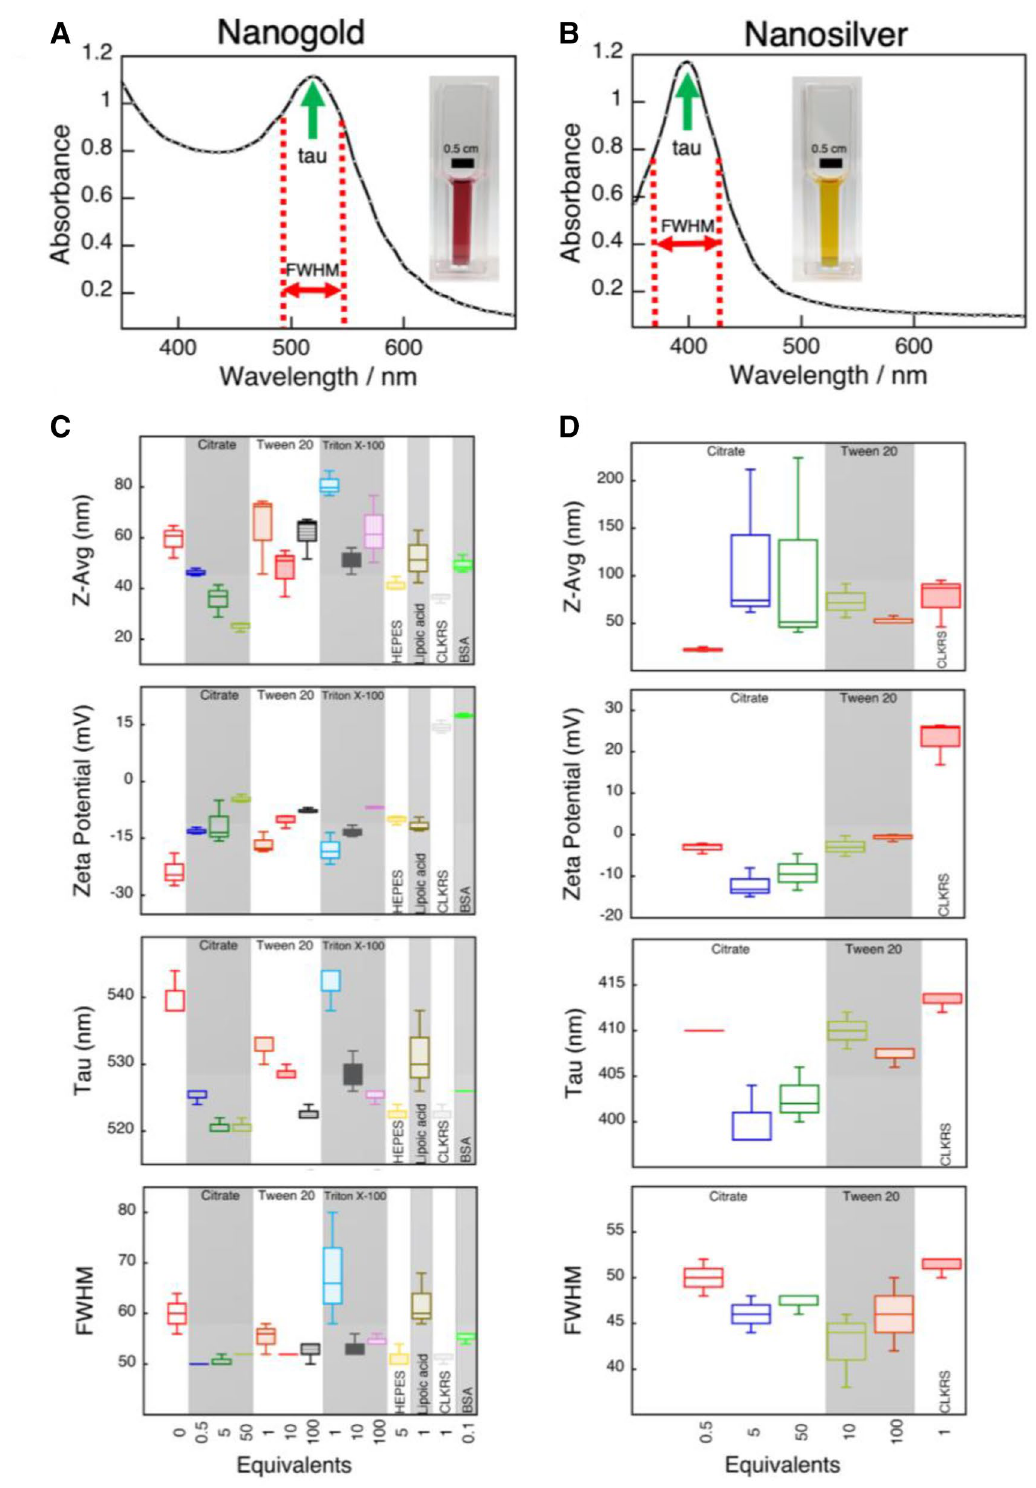
Figure 2. Colloidal properties for nanogold and nanosilver solutions prepared using NPFloSS. NPFloSS allows for rapid nanogold and nanosilver synthesis. Absorption spectra for nanogold ( A ) and nanosilver ( B ) aqueous colloidal solutions prepared using NPFloSS; gold nanoparticles capped with bovine serum albumin and silver nanoparticles capped with CLKRS peptide. The spectra illustrate representative examples for the determination of tau, the wavelength of maximal plasmon band absorbance, and full width at half maximum (FWHM) of the plasmon band. ( C,D ) from top to bottom: Hydrodynamic size, zeta potential, Tau, and FWHM values for gold ( C ) and silver ( D ) nanoparticles prepared in the presence of different protecting agents (see Scheme 1 for synthesis protocol). For each different equivalency of protecting agent, three batches were produced and measured in triplicate. Values in plots ( C,D ) are represented as box plots where the box encloses 50% of the data, upper and lower quartile, with the median value of the variable displayed as a line inside the box. The bars extending from the top and bottom of each box mark the minimum and maximum values within the data set that fall within an acceptable range. Sample size is n = 3 in all cases. See Table S3 for statistical